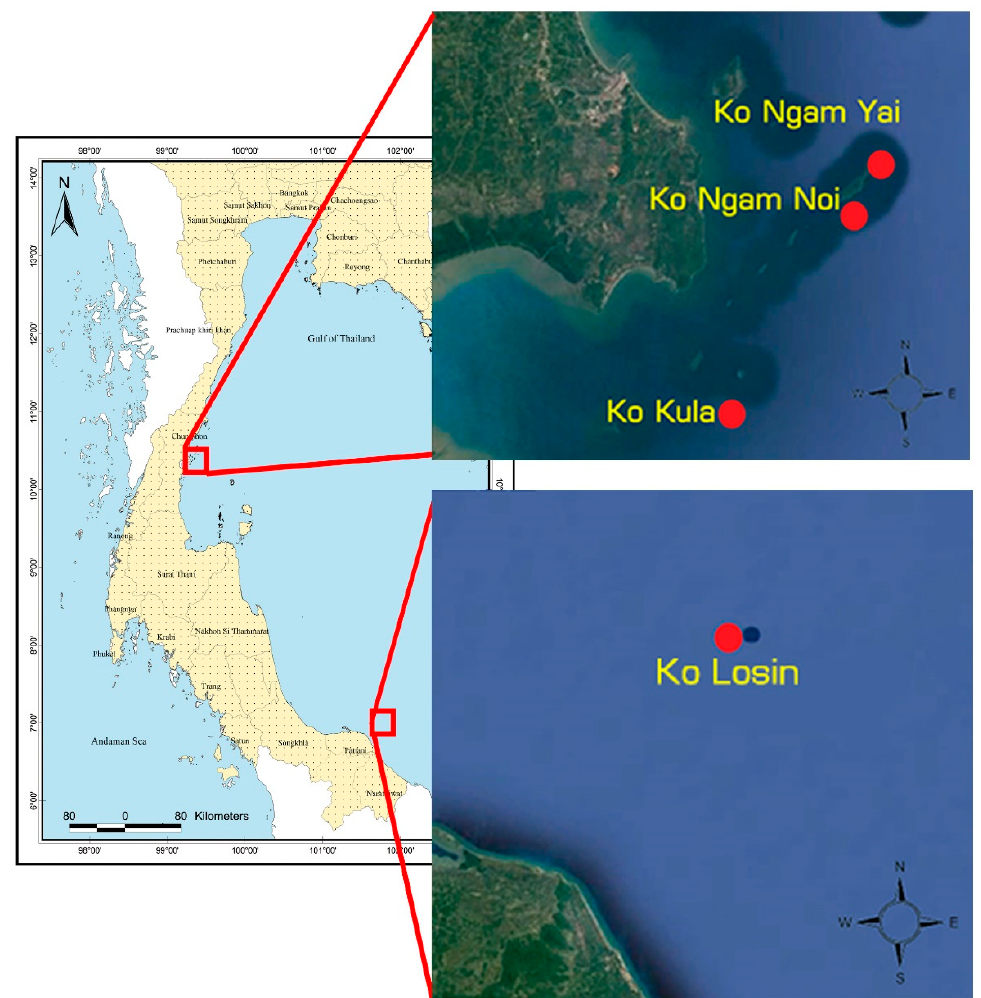
Figure 1. Map of the study sites at Mu Ko Chumphon National Park, Chumphon Province and Ko Losin, Pattani Province.